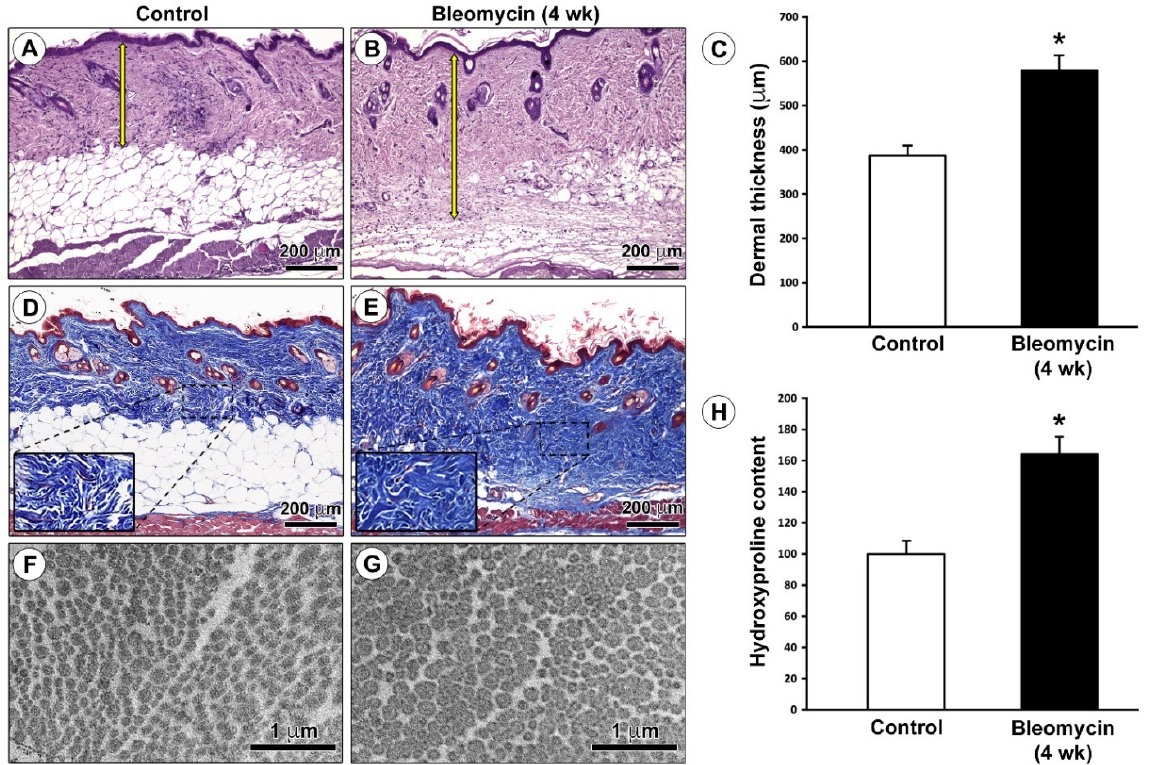
Figure 1. Verification of the mouse model of bleomycin-induced dermal fibrosis. ( A , B ) Representative photomicrographs of hematoxylin- and eosin-stained skin sections from ( A ) control mice and ( B ) mice treated with subcutaneous injections of bleomycin for 4 weeks. Yellow double head arrows indicate the distance between the dermal–epidermal junction and the dermal fibrous connective tissue–dermal white adipose tissue junction (dermal thickness). Scale bar: 200 µ m ( A , B ). ( C ) Quantification of dermal thickness ( µ m). Columns represent the mean and whiskers represent the standard error of the mean; n = 6 mice in each group. * p < 0.001 vs. control (unpaired Student’s t -test). ( D , E ) Representative photomicrographs of skin sections from ( D ) control mice and ( E ) bleomycin-treated mice stained with Masson’s trichrome. The extracellular matrix is stained blue, while cytoplasm is stained red. Note the accumulation of extracellular matrix that replaces dermal white adipose tissue in the skin of bleomycin-treated mice. Insets in ( D , E ) represent higher magnifications of the boxed areas showing more abundant collagen fibers in the dermis of bleomycin-treated mice compared with control mice. Scale bar: 200 µ m ( D , E ). ( F , G ) Representative transmission electron microscopy photomicrographs of skin ultrathin sections from ( F ) control mice and ( G ) bleomycin-treated mice stained with UranyLess and alkaline bismuth subnitrate solutions. Cross-sectioned dermal collagen fibrils of bleomycin-treated mice appear thickened and more closely packed than in control mice. Scale bar: 1 µ m ( F , G ). ( H ) Quantification of hydroxyproline content expressed as a percent of the observed in control mice. Columns represent the mean, and whiskers represent the standard error of the mean; n = 6 mice in each group. * p < 0.001 vs. control (unpaired Student’s t -test). wk,